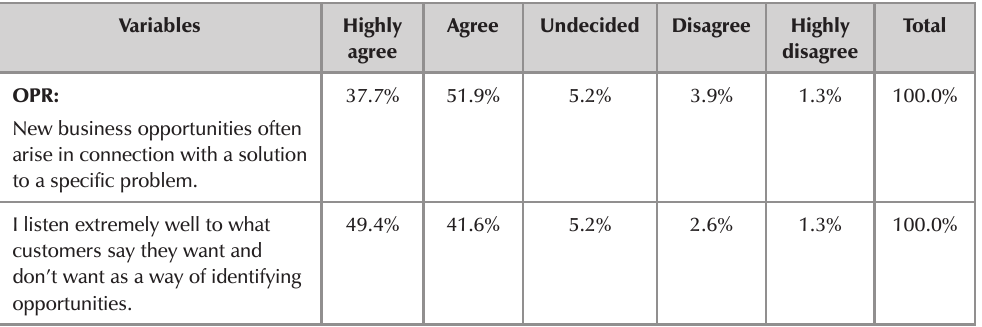
Percentage analysis for OPR and motivator items (N =